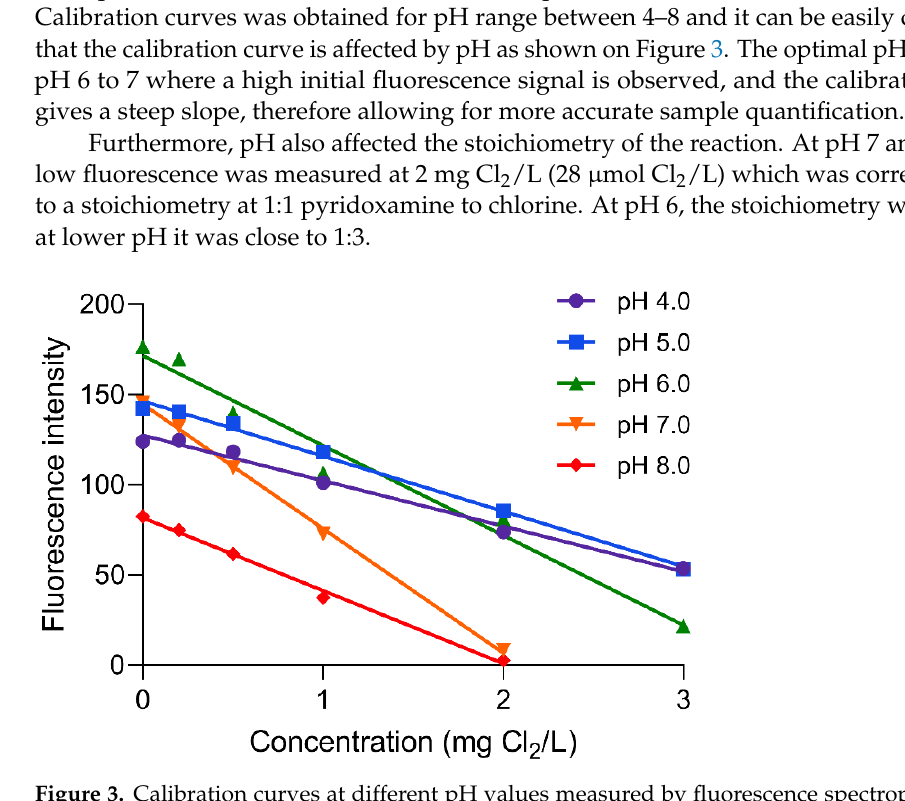
Figure 3. Calibration curves at different pH values measured by fluorescence spectrophotometer (1 mL pyridoxamine 25 µ M, 1 mL sample, λ ex 330 nm, λ em 396 nm). The R 2 was >0.97 for all lines. Fluorescence intensity on vertical axis shown with arbitrary units.